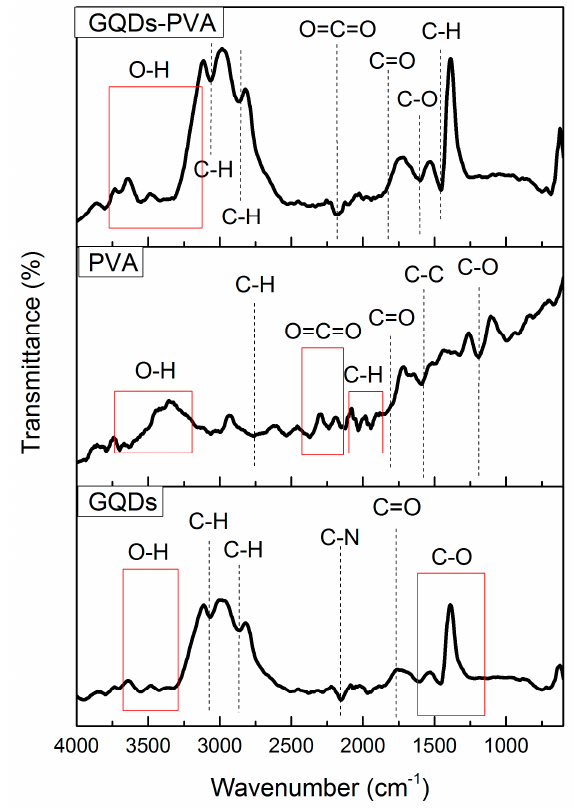
Figure 4. FTIR spectra of GQDs, PVA, and GQDs − PVA.